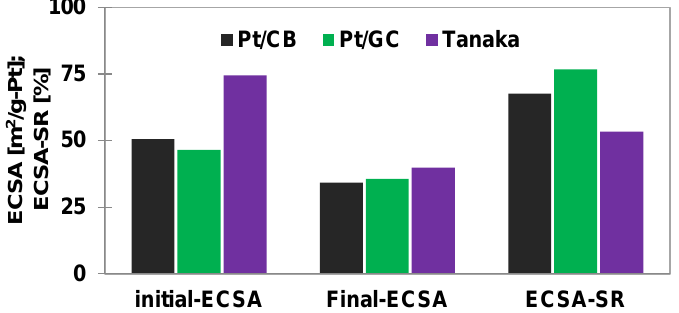
Figure 4. Comparison of Pt stabilities on the supports (in terms of ECSA survival rate) during potential cycling between 0.6 V and 1.0 V vs. RHE at 50 mV/s voltage scan rate in 0.5 M H 2 SO 4 electrolyte at 25 °C.